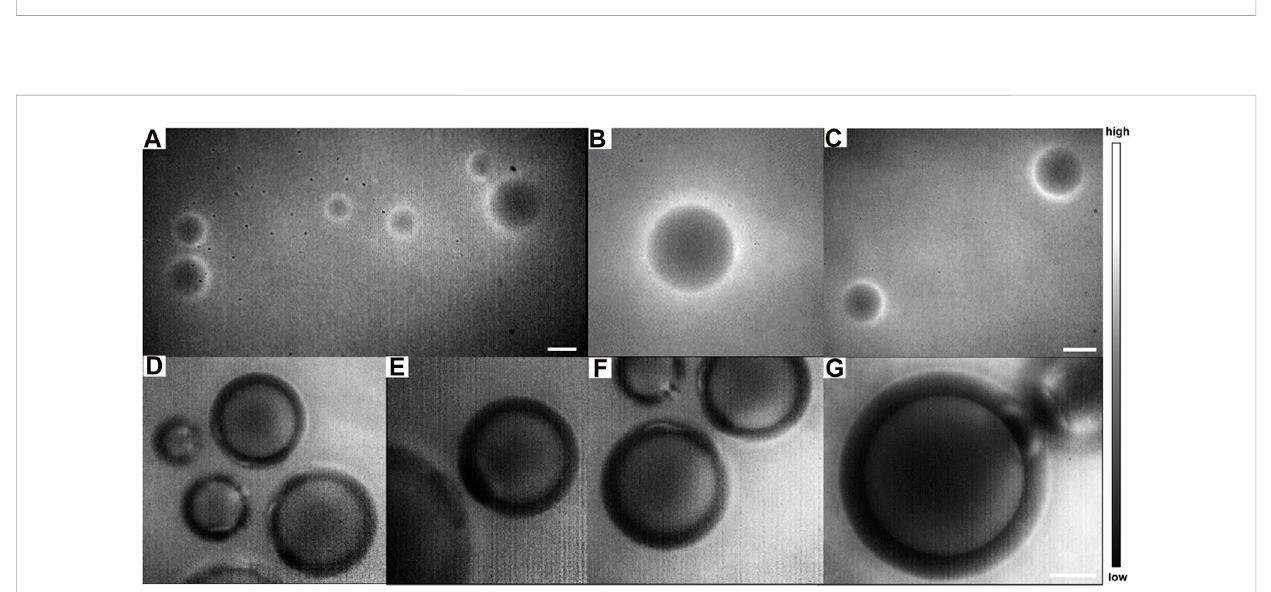
FIGURE 7 (A) Typical NIR-II fl uorescence microscopic image of (E) multilocularis-infected mice at the early stage. (B, C) I n vivo NIR-II fl uorescence microscopic images of (E) multilocularis-infected mice post ICG injection. (D, E) NIR-II fl uorescence microscopic images of portal vein angiography injected with ICG. (F) Typical CT image of (A) . (G) Typical image of (E) multilocularis-infected liver tissues at the early stage under the NIR-II-FMI system. (H – I) In vitro NIR-II fl uorescence microscopic images of (E) multilocularis-infected liver tissues and the corresponding H&E images. λ excitation = 808 nm. (J) H&E-stained liver tissues taken from HAE mice (inset: the lesion location is shown by the yellow circle).